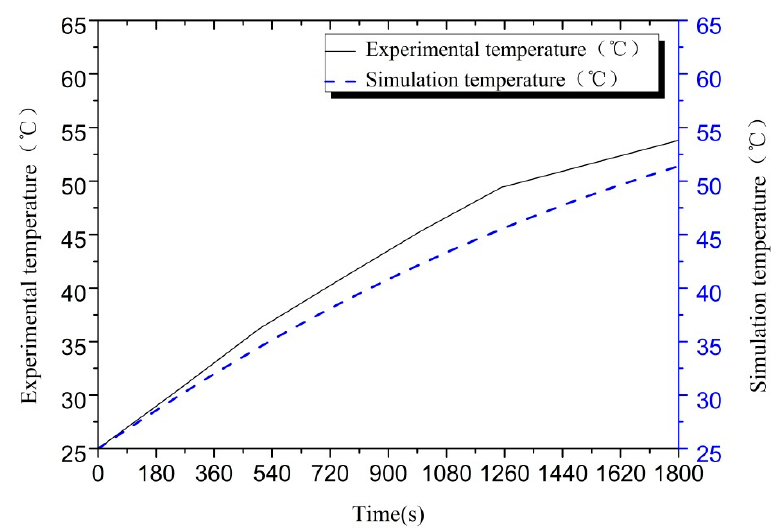
Figure 4. Temperature curve of simulation and experiment.